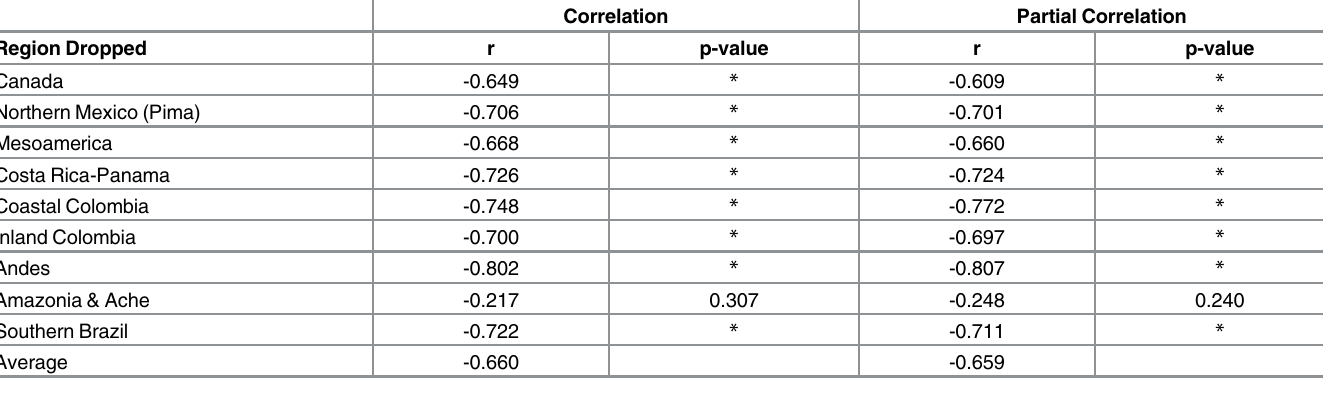
Table 1. Region-level Jackknife Results.